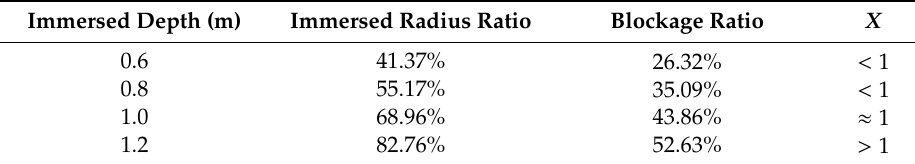
Table 2. The main characteristic